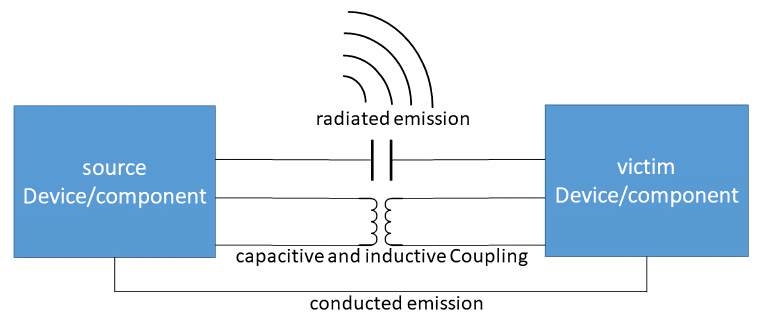
Figure 2. Sketch of the different kinds of electromagnetic